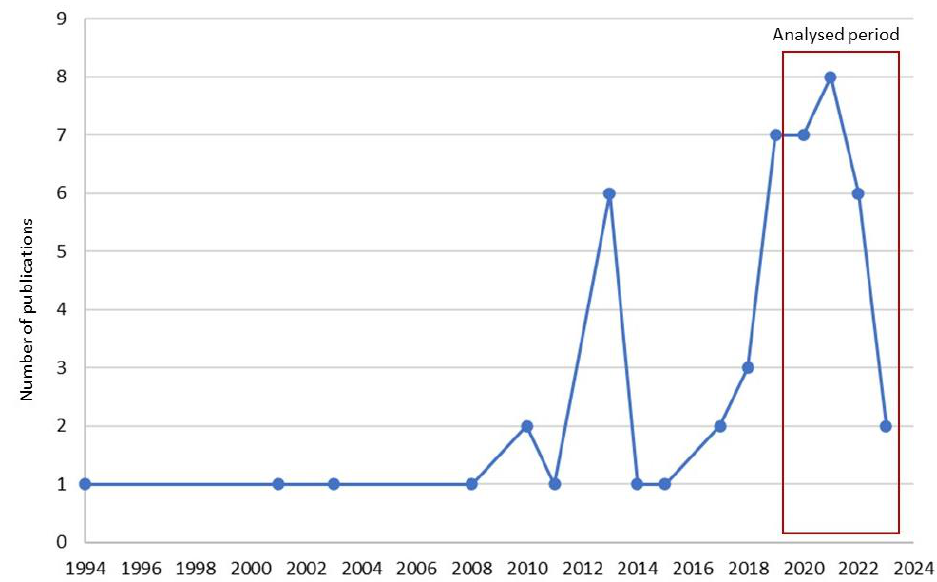
Figure 1. Chronological view of the studies on solar energies and cultural heritage: 50 scientific manuscripts have been realized from 1994 to 2023, 23 of them in the years 2020 – 2023 (Source: Au- thor ’ s elaboration using Scopus data).